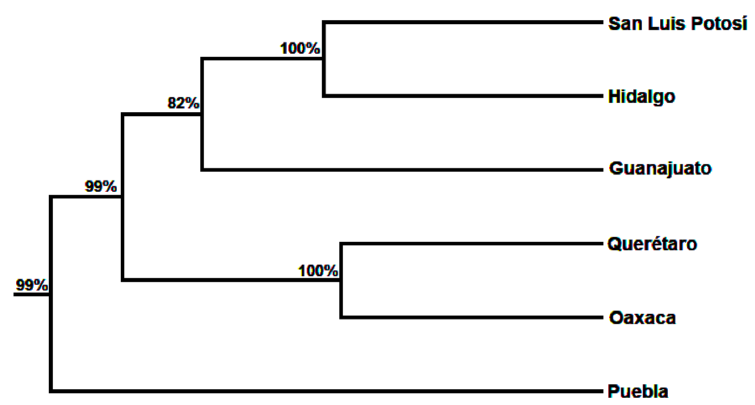
Figure 6. UPGMA dendrogram based on genetic distance ( FST ) using a bootstrapping of 1000